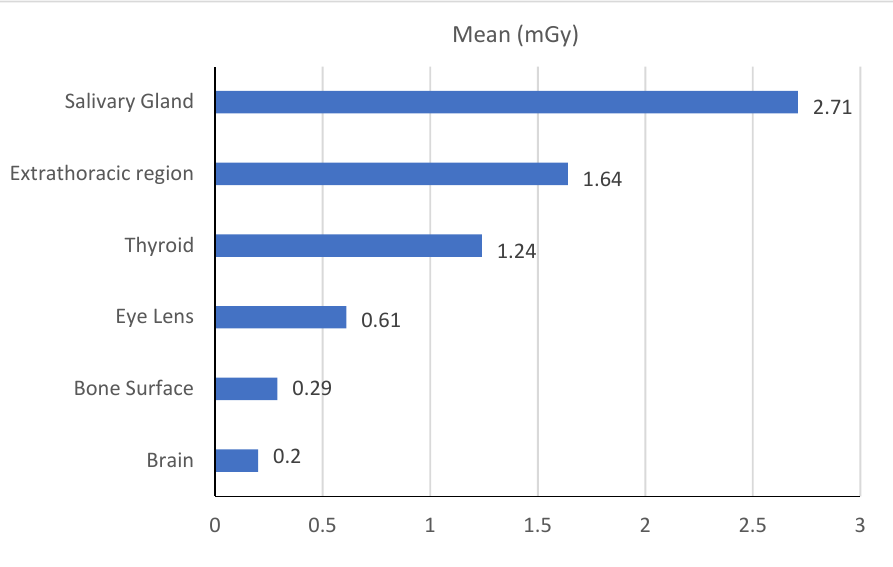
Figure 2. Mean organ dose (mGy) during CBCT procedure.